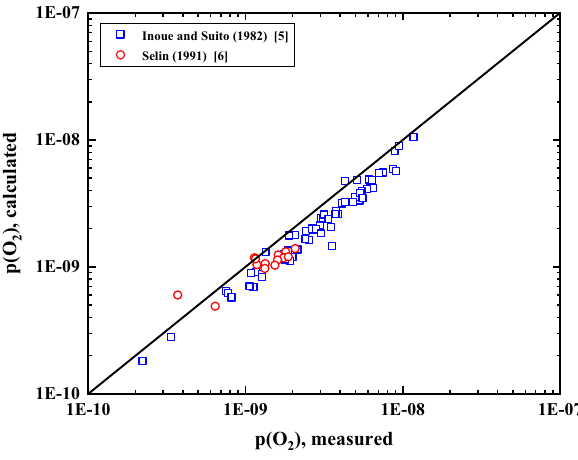
Figure 1: Comparison of the calculated oxygen particle pressure p ( O ) with the experimental measurements [ 5,6 ] 2